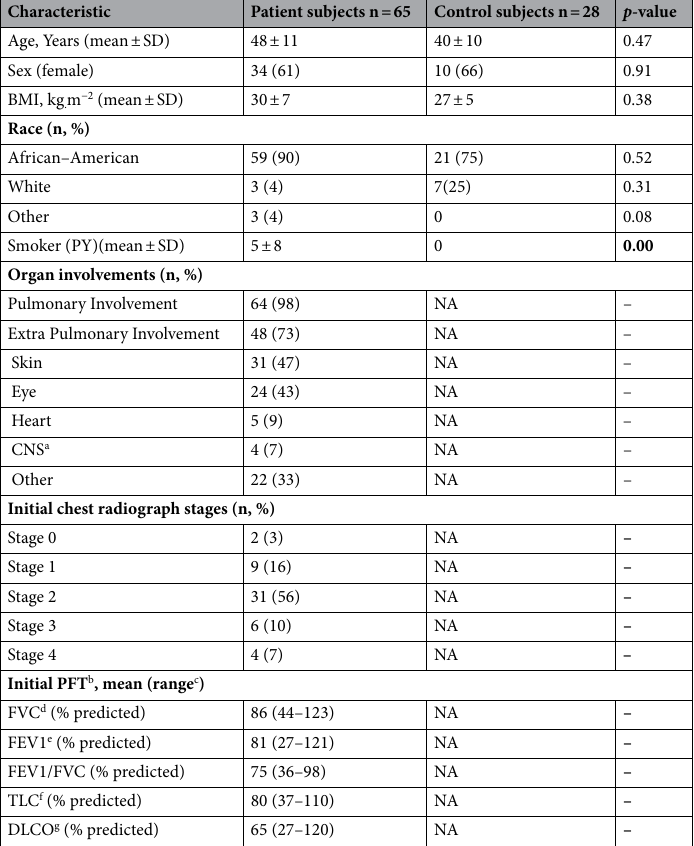
Table 1. Subject demographics. a Central nerve system, b Pulmonary function test, c Range, d Forced vital capacity, e Forced expiratory volume, f Total lung capacity, g Diffusing capacity of the lung for carbon monoxide. Significant values are in